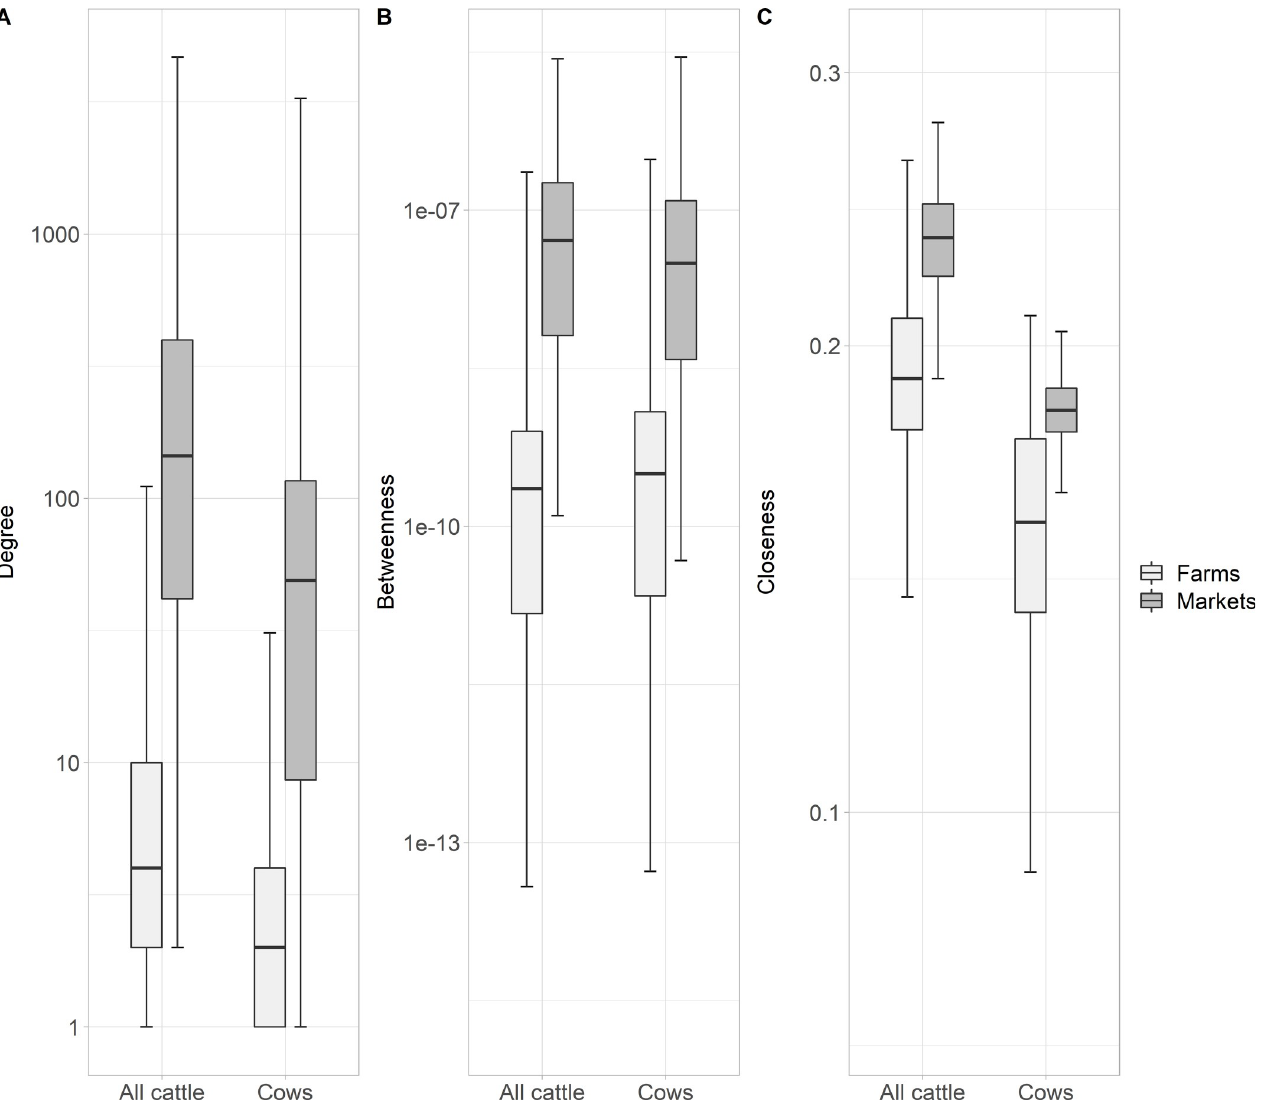
Fig 6. Distribution of centrality indicators for all cattle and cows in global networks differentiating farms and markets. (A) Degrees, (B) betweenness, and (C) closeness calculated in the largest strongly component (nodes and links aggregated from 2014 to 2018). https://doi.org/10.1371/journal.pone.0278999.g006 lower. Average values for betweenness for all cattle were 1.78.10 − 5 (0–3.10 − 4 ) and were higher for the only cow networks. Closeness ranged from 0.38 to 0.81 for all cattle, and from 0.32 to 0.72 for the only cow networks. For the annual networks, the average degree ranged from 63.83 to 77.26 for all cattle, and from 30.48 to 34.20 for only cow; the betweenness 2.34.10 − 5 to 2.52.10 − 5 for all cattle, and 3.25.10 − 5 to 3.47.10 − 5 for only cows; and the closeness around 0.47 to 0.49 for all cattle and 0.40 to 0.41 for only cows. For monthly networks, the average degree presented values between 7.7 and 24, with lower values in cows (4.5–10.7), for betweenness values ranged from 0.005 to 0.008 for all cattle, and 0.003 to 0.009 for only cows. Other indicators. Density values were slightly higher for the all cattle global networks compared to those for the only cow networks at the holding level (Table 4) . The holdings in global networks were linked on average by fewer edges in the all cattle global network (average